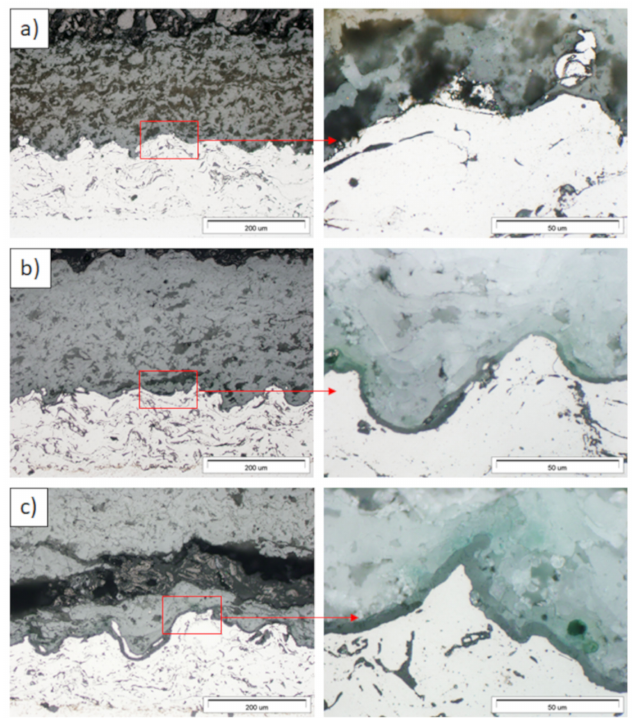
Figure 12. Ceramic layer / bond-coat interfaces of the TBC systems as a function of oxidation time at a